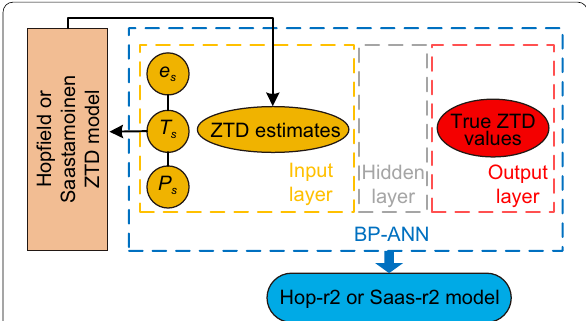
Fig. 1 Flowchart in the establishment of Hop-r2 and Saas-r2 models based on